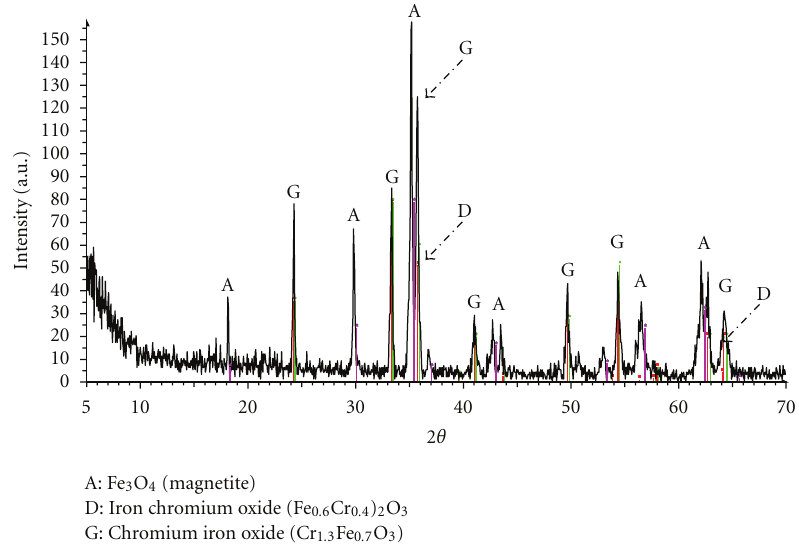
Figure 4: X-ray di ff raction image for AISI 316 stainless steel oxidized in synthetic air at T = 1000 ◦